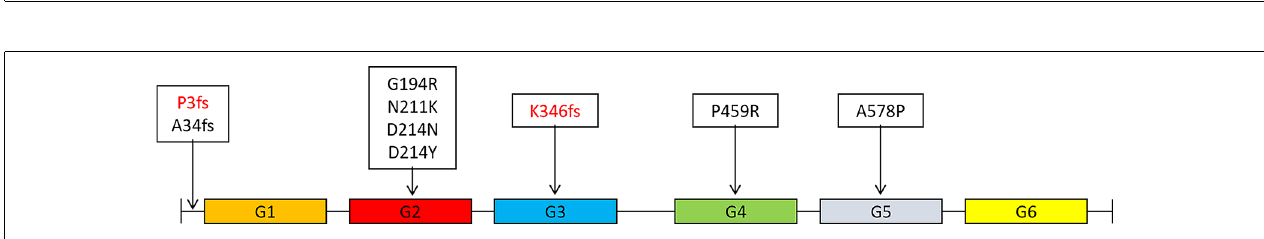
FIGURE 2 | Distribution of mutations in the GSN gene in different domains of gelsolin protein (Gelsolin protein has six domains, named G1 to G6).